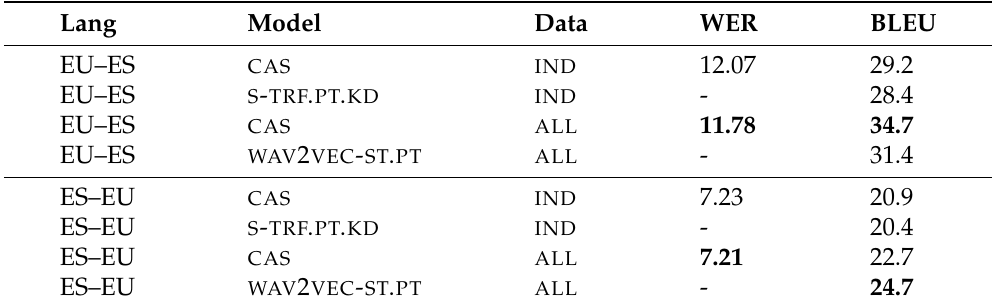
Table 12. Summary of the results with cascade and advanced end-to-end models. Best-performing systems are indicated in